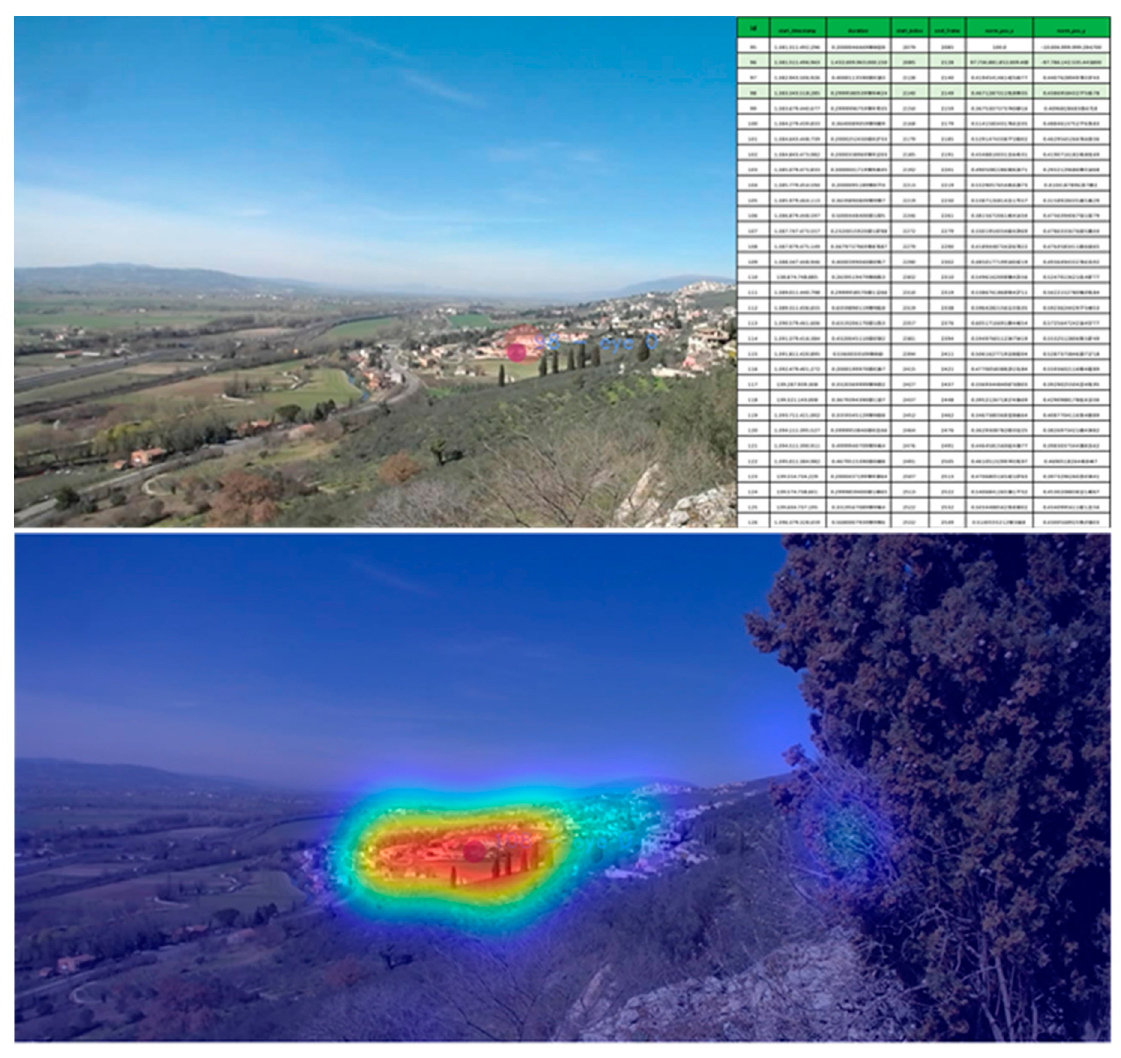
Figure 4. Pupil results Player and Heat